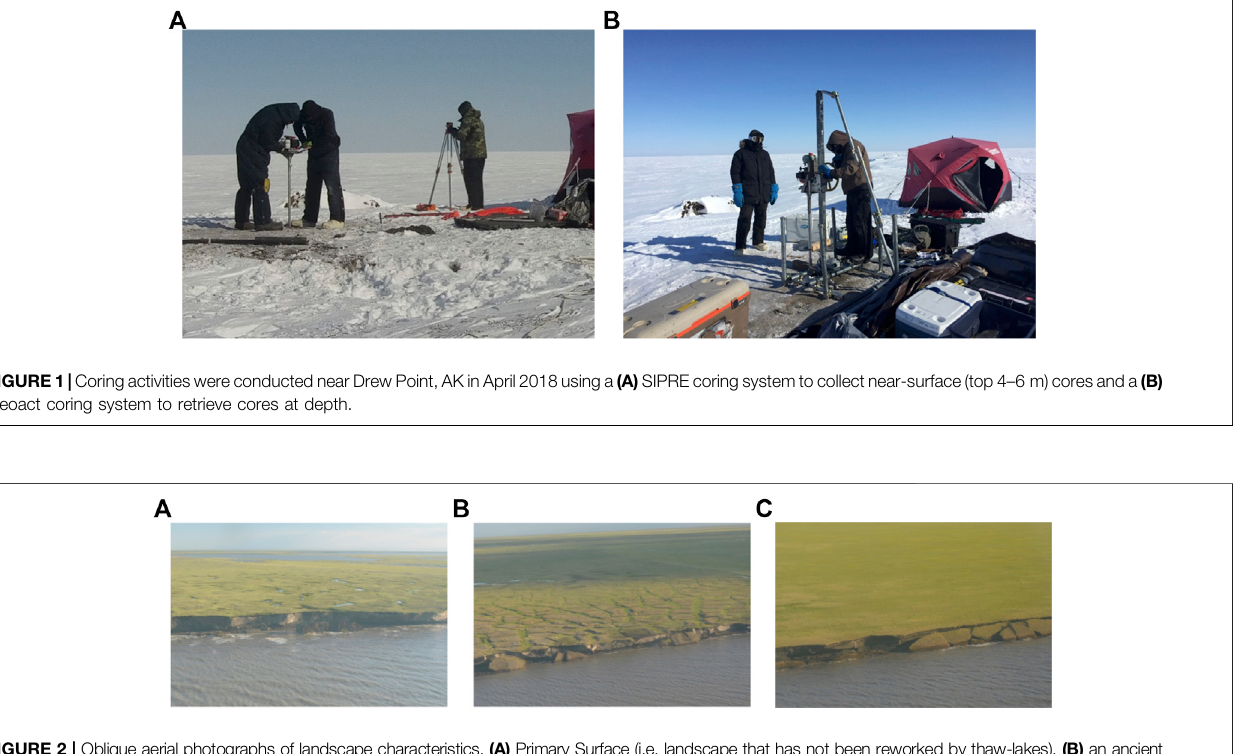
FIGURE 2 | Oblique aerial photographs of landscape characteristics. (A) Primary Surface (i.e. landscape that has not been reworked by thaw-lakes), (B) an ancient drainedthermokarstlakebasin(AncientDTLB)thatdrained ∼ 5 kyrBP,and (C) ayoungdrainedthermokarstlakebasin(YoungDTLB)thatmostrecentlydrained ∼ 0.5